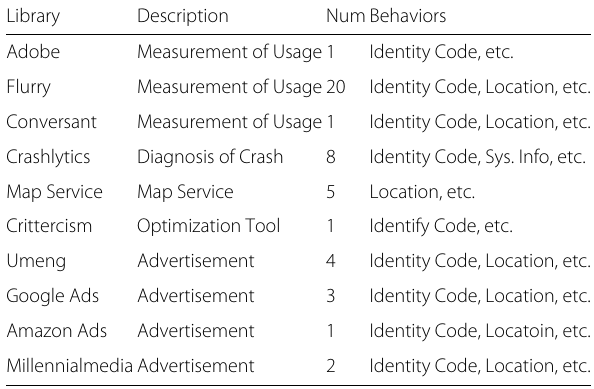
Table 4 Privacy leakage via